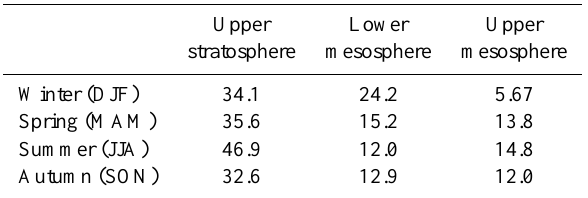
Table 1. Seasonal averages of the kinetic energy density (mJ/m 3 ) . Upper Lower Upper stratosphere